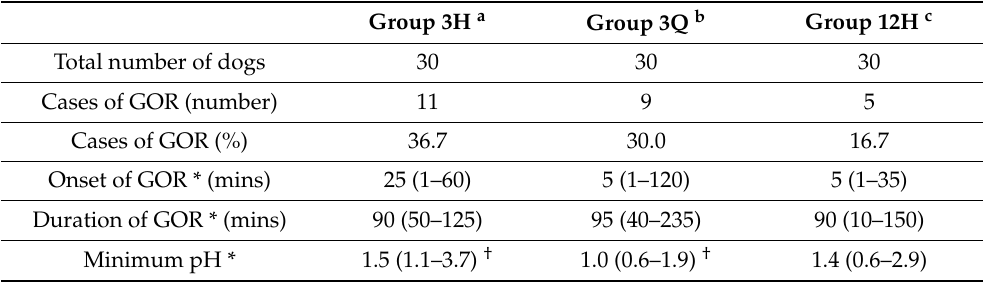
Table 2. Descriptive statistics of the episodes of gastro-oesophageal reflux (GOR) in each of the three study